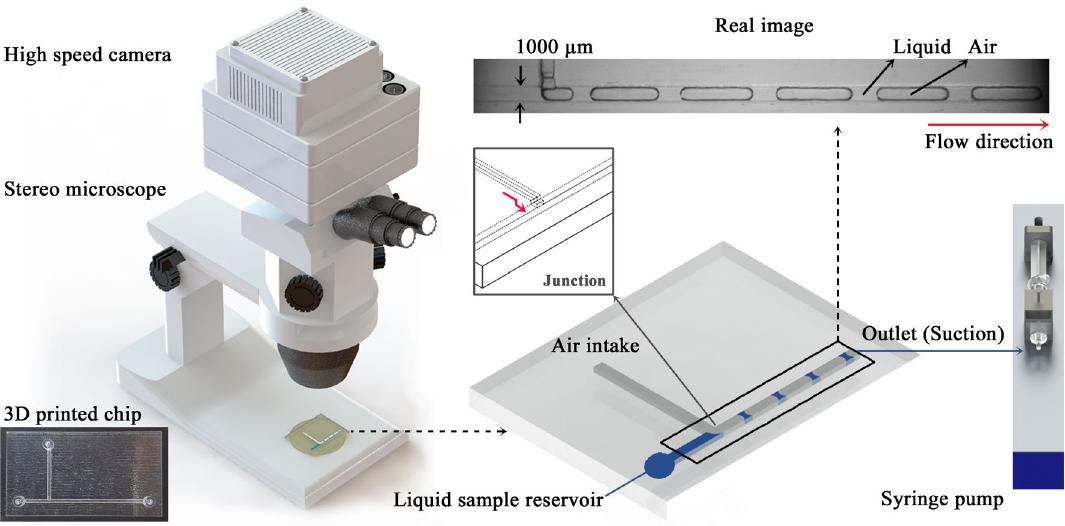
Figure 1. Experimental setup composed of a high-speed camera, a stereo microscope, a 3D-printed chip, and a syringe pump. T-shaped rectangular channel with a width and depth of 1000 µm for a mainstream channel with a length of 45 mm, and a depth of 500 µm for a 90° channel with a length of 20 mm. 3D illustrations were produced by the authors using SolidWorks software (Dassault Systèmes SolidWorks Corp.,